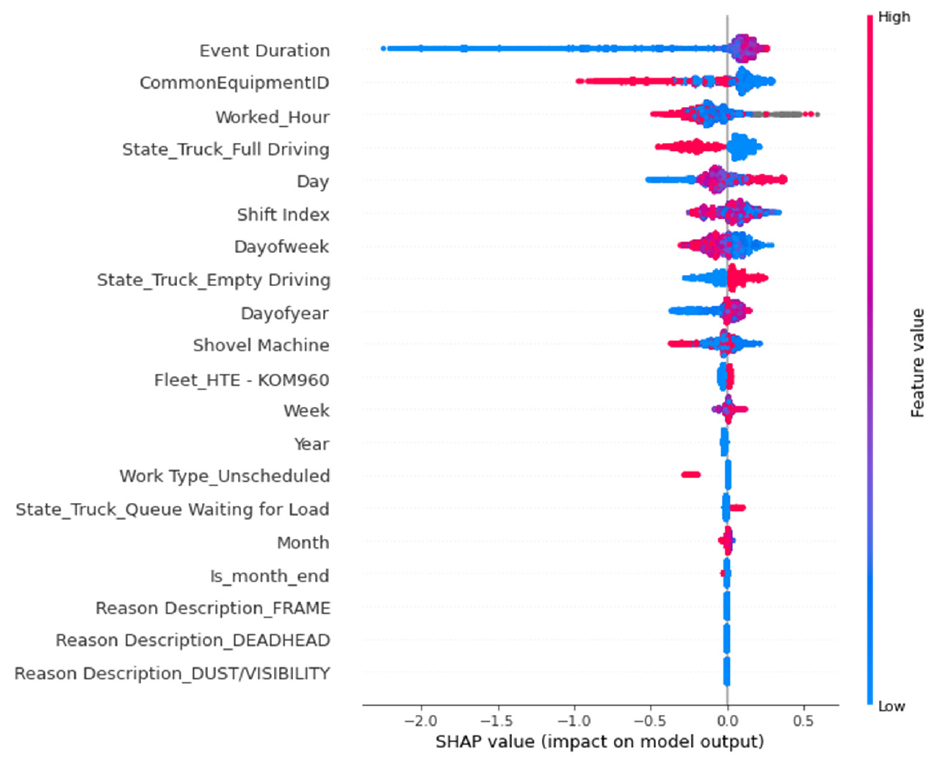
Figure 13. SHAP value of the fourth model.